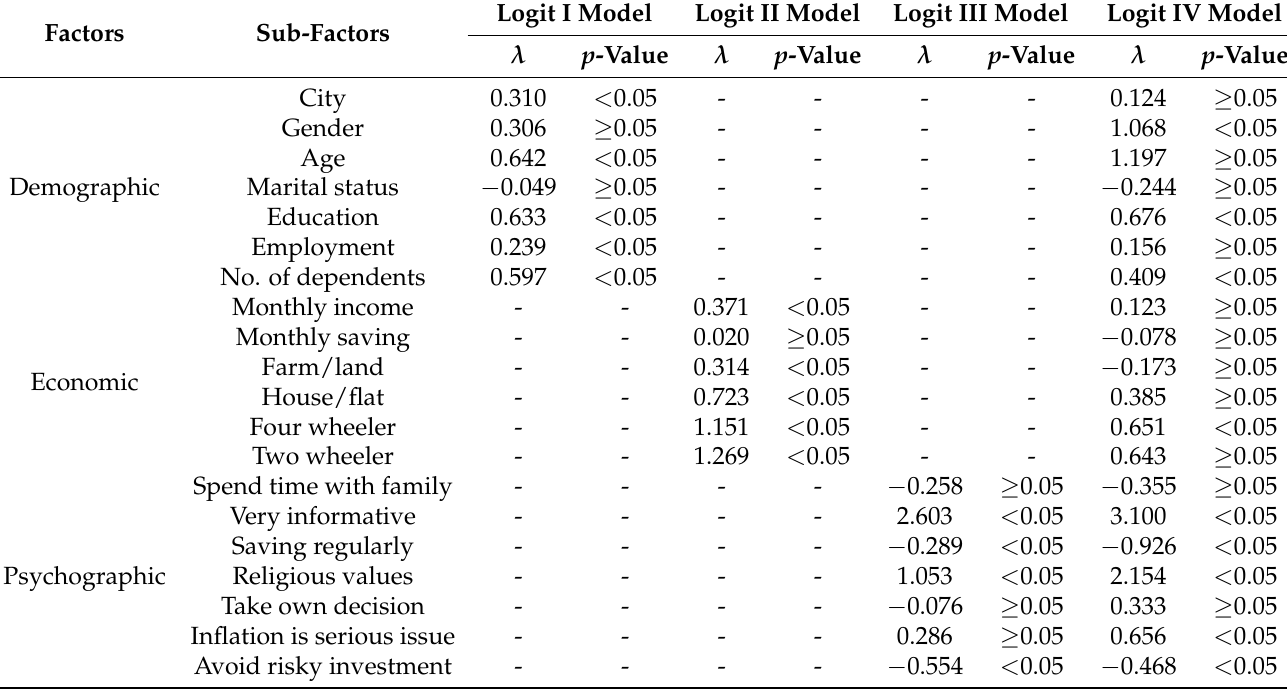
Table 8. Logistic regression models of respondents’ buying behaviour on demographic, economic and psychographic factors.